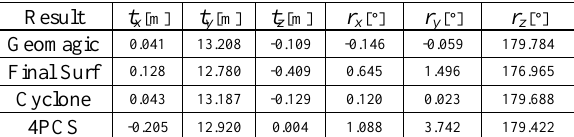
Table 1: Comparison of all obtained transformation parameters